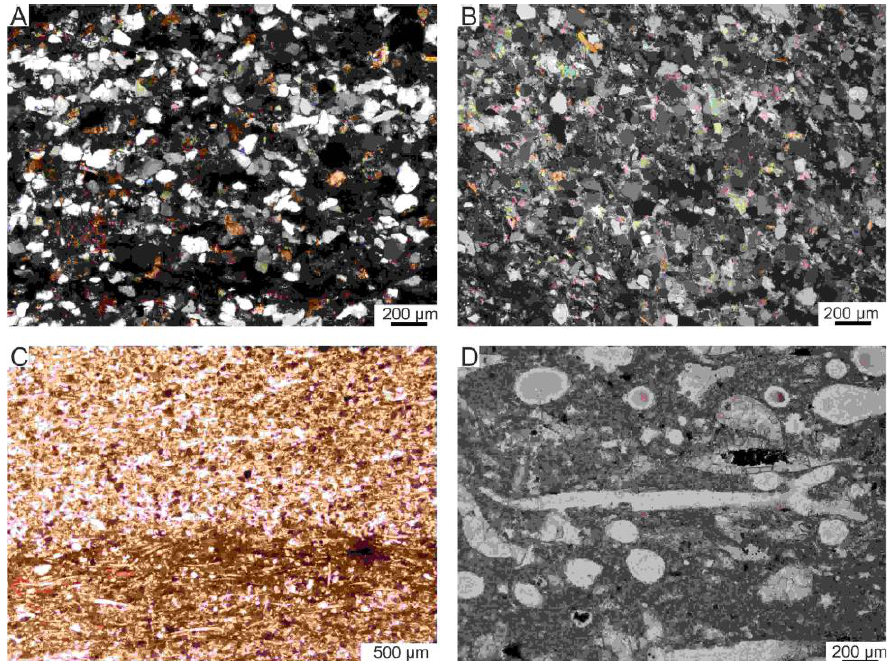
Figure 6. Examples of microfacies dominated by sand-sized particles in the Mikuszowice Chert Beds. ( A , B ) Sublitharenite (subsection A), ( A ) — sample J3243, ( B ) — sample J3226; ( C ) Spiculite with seams which are matrix-supported and more clayey contains radiolarian skeletons (subsection C), sample J3100; ( D ) Details of spiculite showing different cross-sections of spicules of siliceous sponges which are calcified (subsection C), sample J3105. All photos oriented perpendicular to layering.